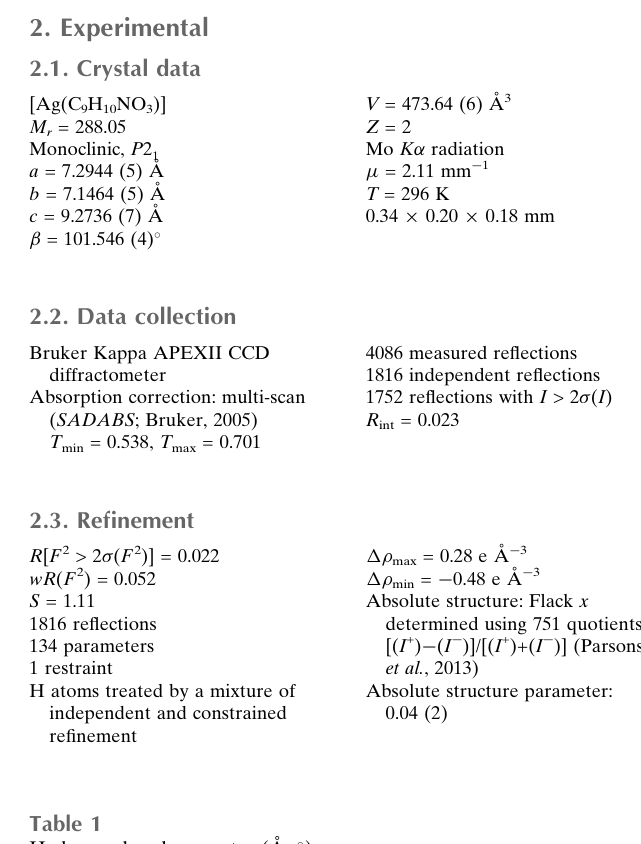
Hydrogen-bond geometry (A˚ , (cid:2)